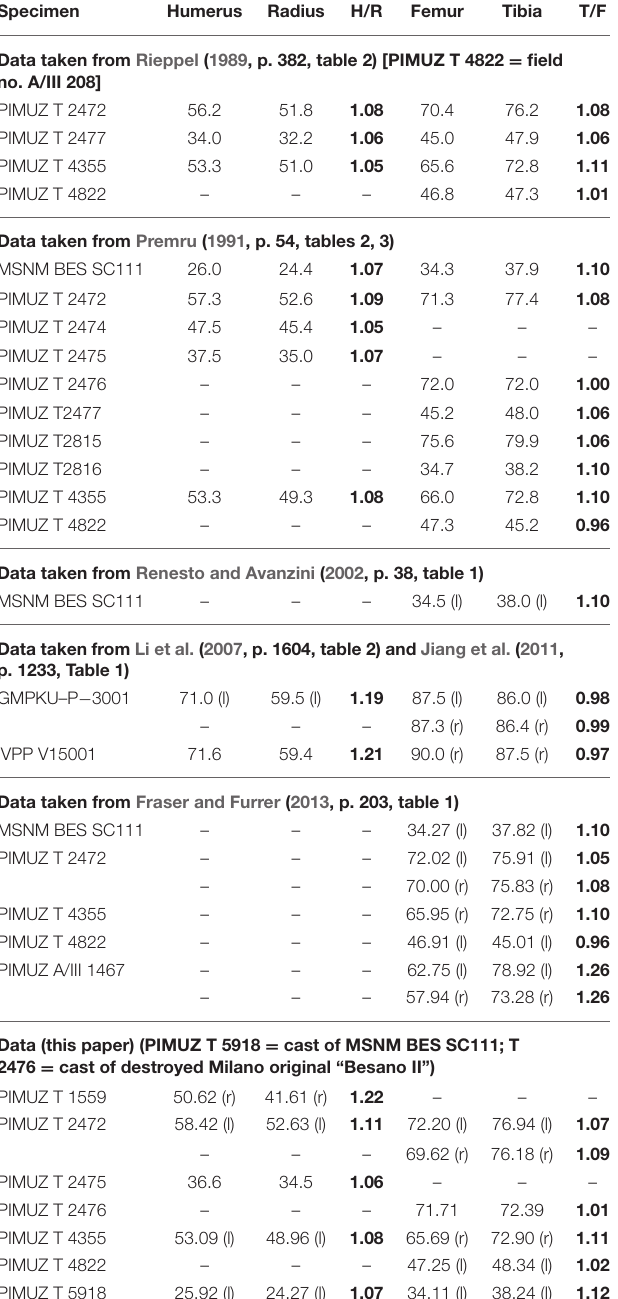
TABLE 6 | Measurements (in mm) of stylopodial and zeugopodial elements in various Macrocnemus specimens. Specimen Humerus Radius H/R Femur Tibia T/F